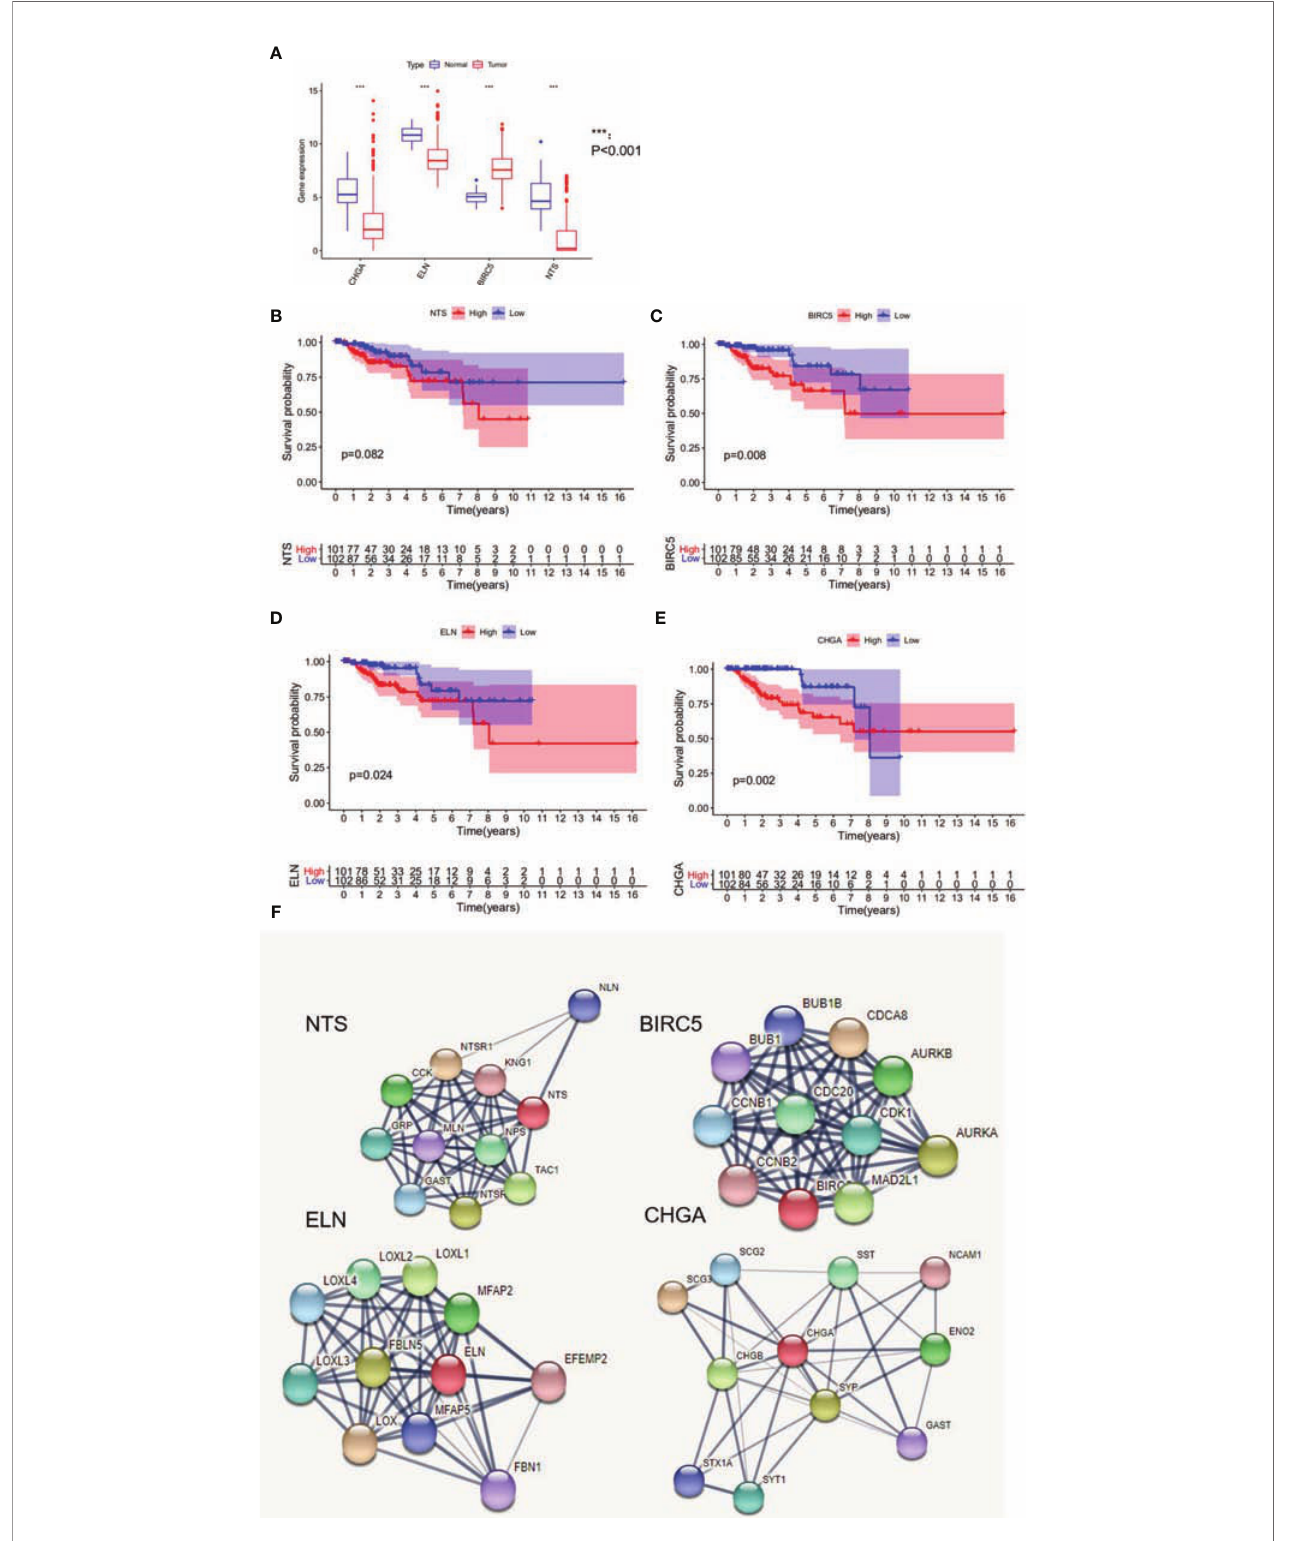
FIGURE 3 | The analysis of hub DEGs ’ expression, survival results, and protein – protein interaction. (A) The mRNA expression of four hub DEGs in normal vs tumor tissue; (B – E) the survival results in Kaplan-Meier analysis; (F) the protein-protein interaction of four hub